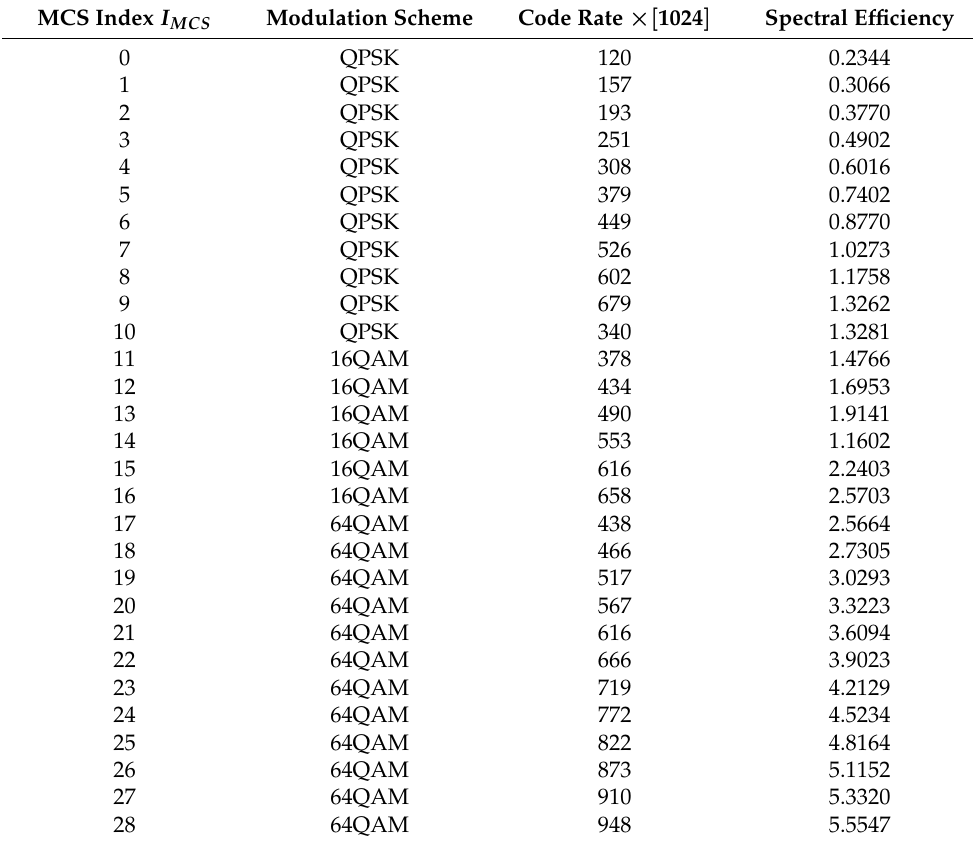
Table 2. MCS index table for Physical Downlink Shared Channel